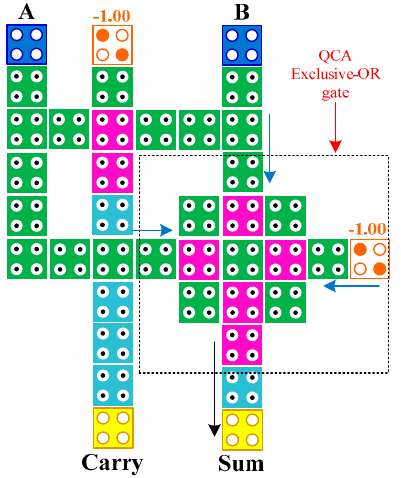
Figure 4. The proposed half adder.